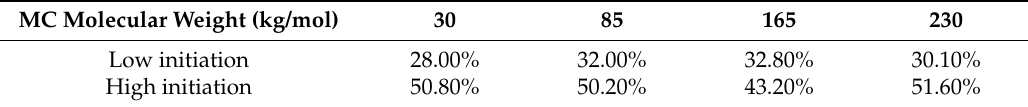
Degree of hydrophobization (DH) for various MC molecular weights and initiator